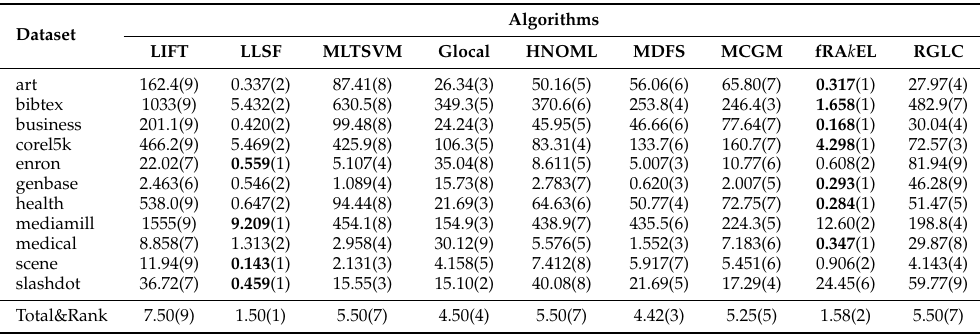
Table 6. Runtime (in seconds) for learning with 60% noisy features and missing labels. Best results are in bold